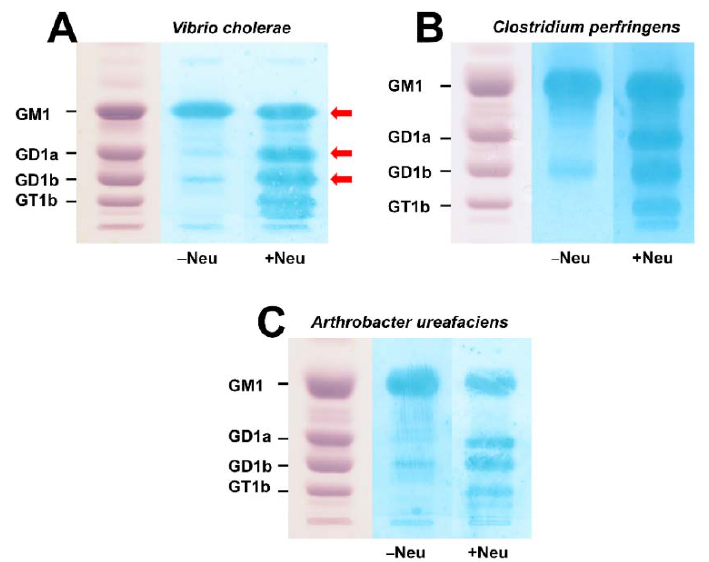
Figure 2. Detection of GM1 in a reference mixture of human brain gangliosides before and after treatment with the neuraminidase of Vibrio cholerae ( A ), Clostridium perfringens ( B ), and Arthrobacter ureafaciens ( C ). GM1 was detected without ( − Neu) and after neuraminidase treatment (+Neu) by means of TLC overlay assays using choleragenoid (cholera toxin B subunit). Amounts of 15 µg of human brain gangliosides (HBG) were applied for the orcinol stains (left lanes of panel A, B, and C) and 1 µg for each overlay assay without ( − Neu) and after neuraminidase treatment (+Neu). Structures of GM1, GD1a, GD1b and GT1b are shown in Figure 1. Mass spectrometric characterized gangliosides obtained from the silica gel extracts of TLC bands at the positions of GM1, GD1a and GD1b (see Figure 3), marked with red arrows, are listed in Table 1.